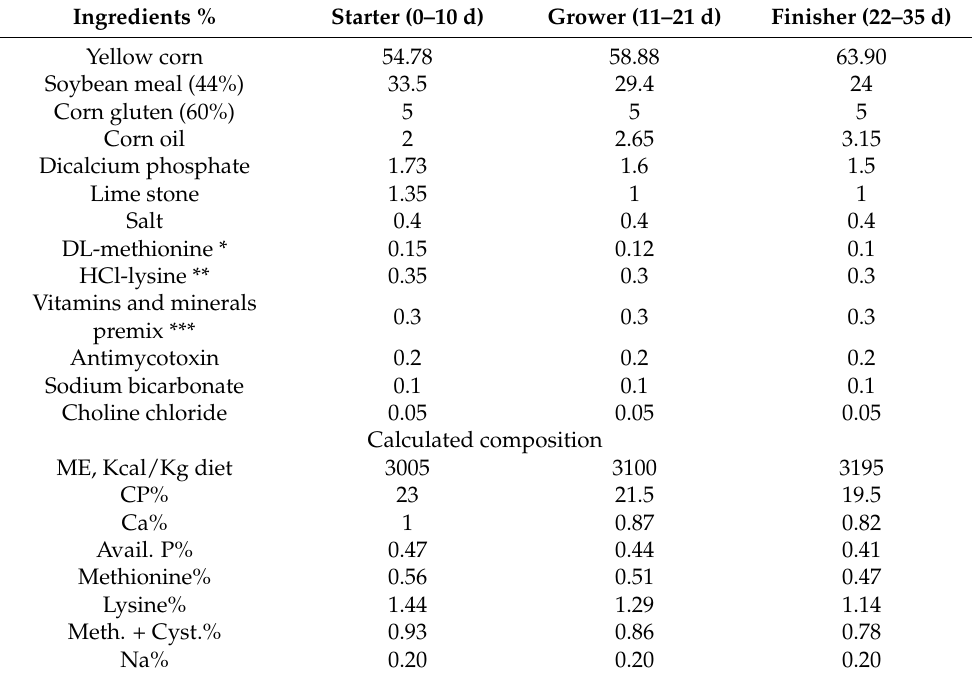
Table 1. Ingredients’ percentage and calculated composition analysis of the experimental starter and grower diets (%, as-fed